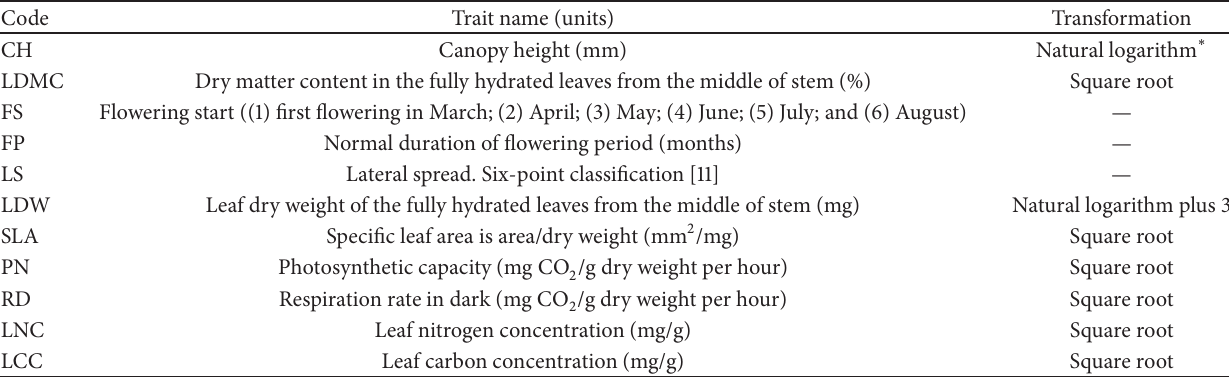
Table 1: Definition (units) of the predictor variables and method for its transformation in models.